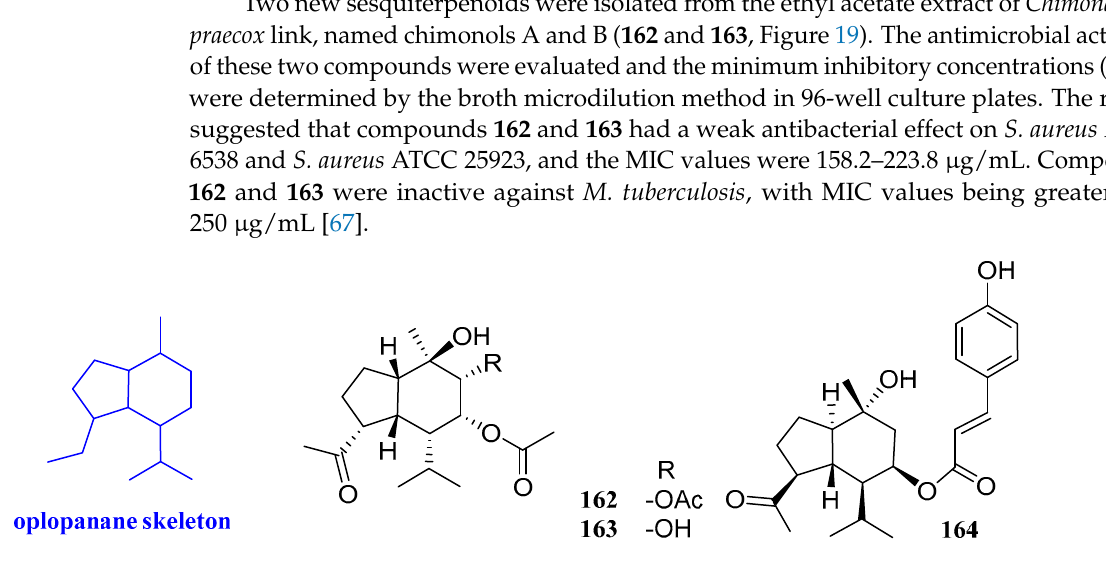
Figure 19. Structures of oplopanane - type sesquiterpenoids 162 – 164 .